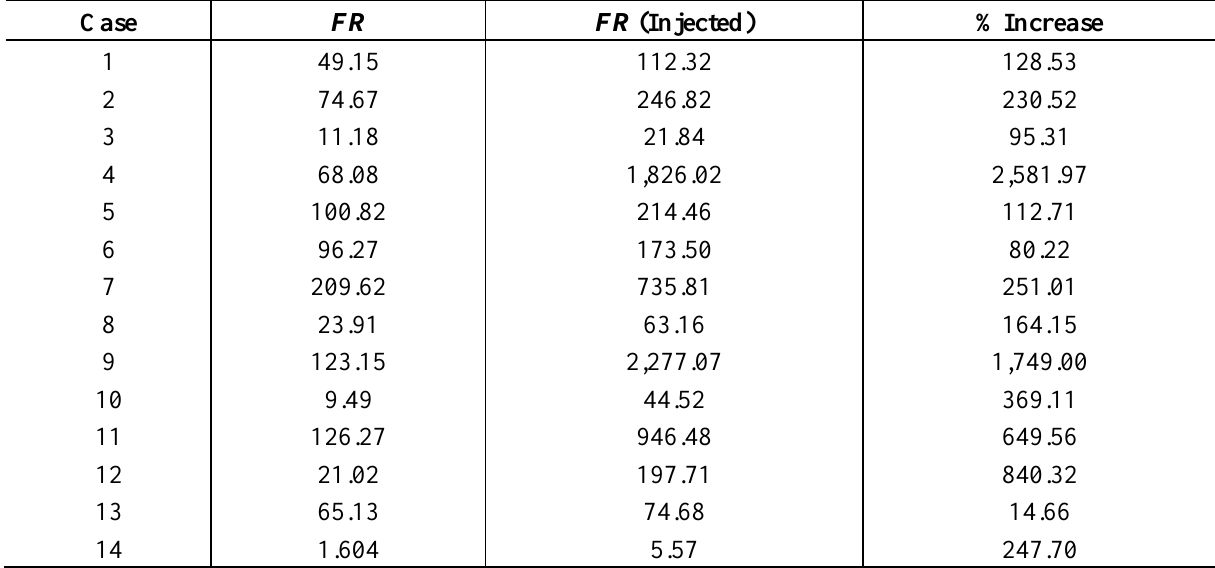
Table 1. FR results for 14 cases in this